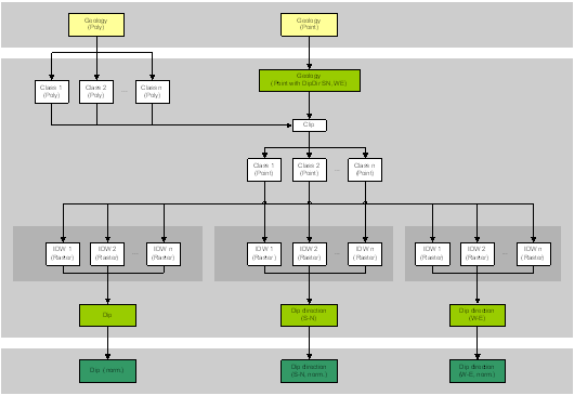
Figure 4. Example of a workflow for processing